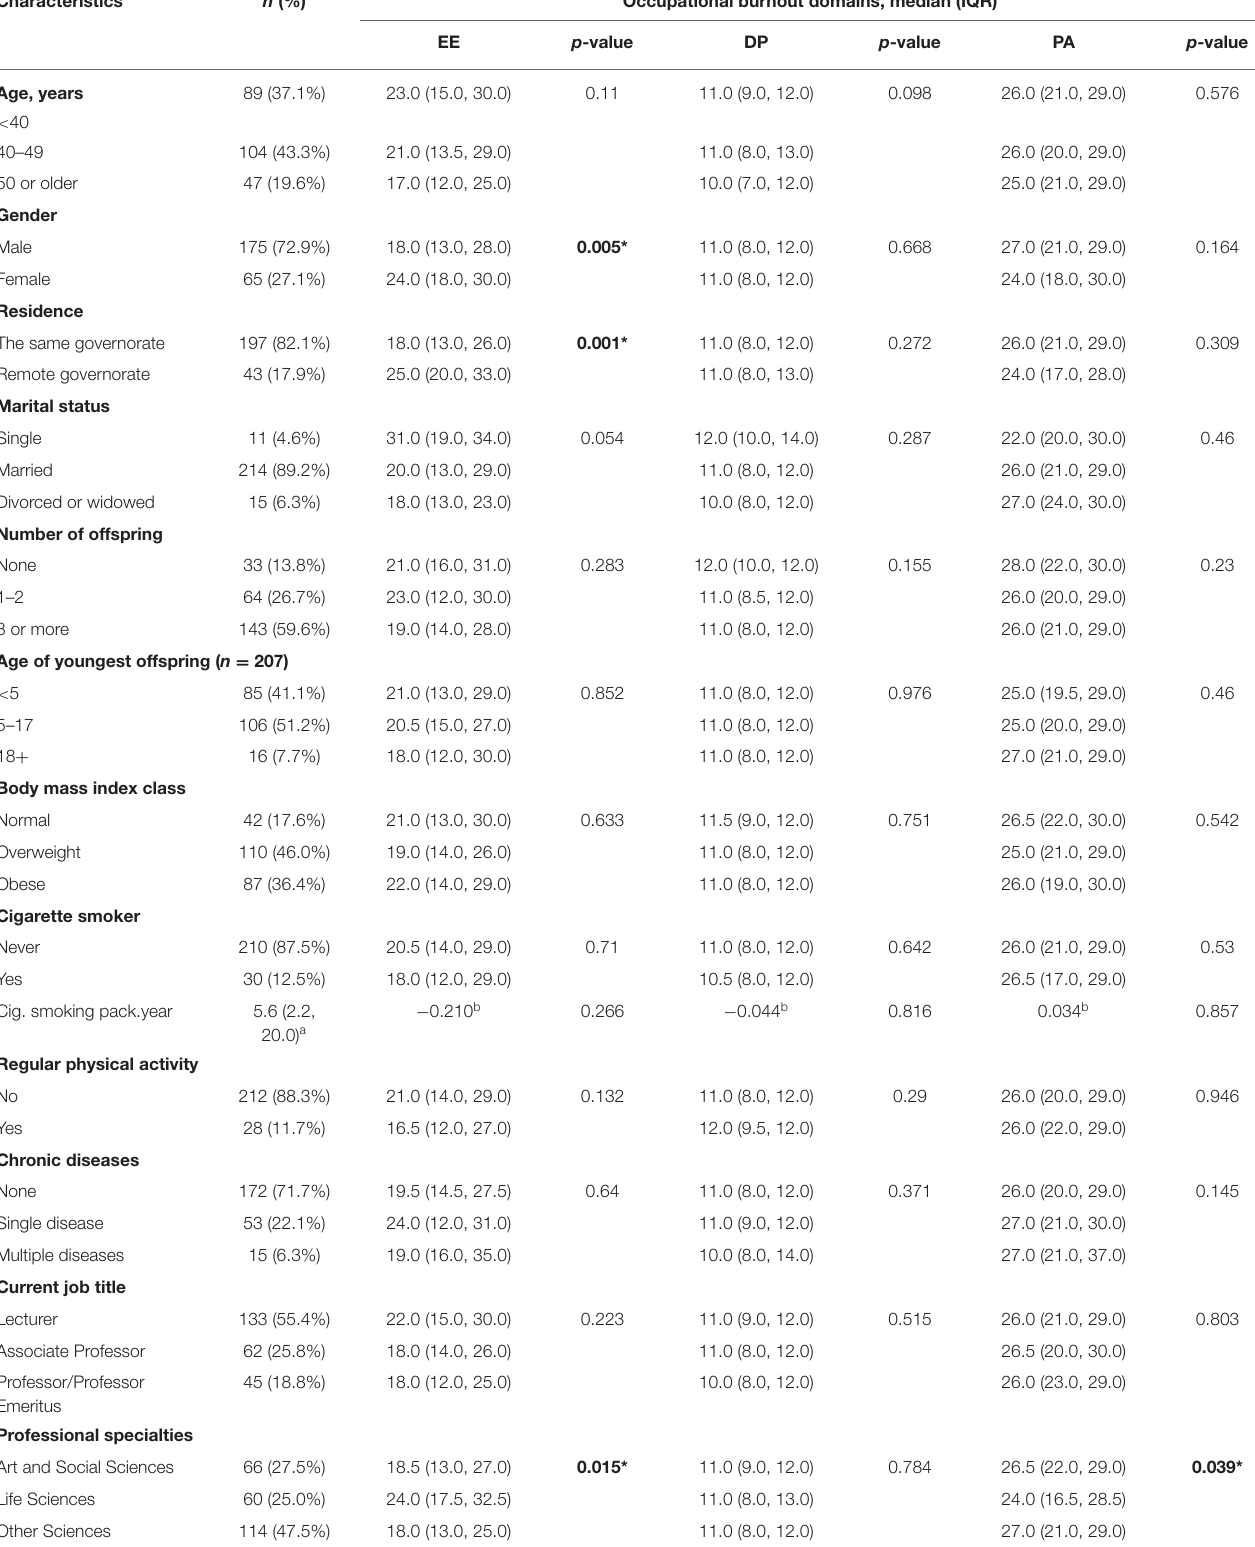
TABLE 1 | Distribution of respondents’ burnout scores by their demographic, health, and work characteristics ( N = 240).